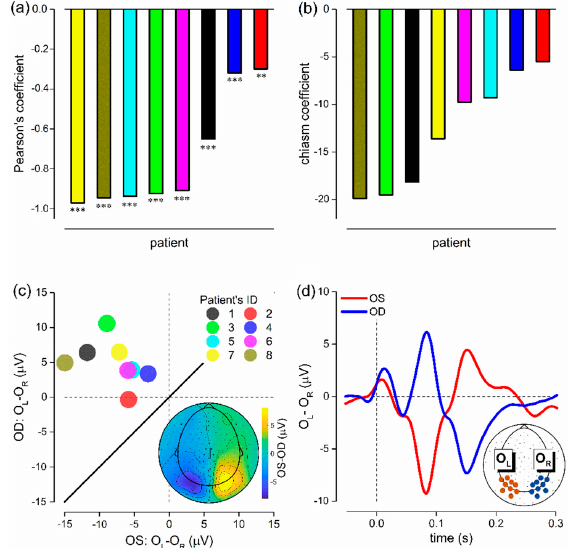
Figure 4. Misrouting of the optic pathway. ( a ) Pearson’s coefficient of correlation computed between the OS and OD mean differential activity (OL-OR, from 0.07 to 0.3 s). Each bar represents a patient (color codes for patients is consistent across panels, see panel c). The within-subject correlation was statistically significant for all patients ( p ≤ 0.0011. Asterisks mark the statistical significance: *** < 0.001, ** < 0.01). ( b ) Chiasm coefficient computed between the OS and OD mean differential activity (OL-OR, from 0.07 to 0.1 s). Each bar represents a patient. ( c ) Scatter plot showing the average dif- ferential activity for both OS and OD. Each dot represents a patient. All the dots scattered above the equality line (thick, black) indicate the presence of a significant interhemispheric difference ( p > 0.001). The topoplot inset shows the grand-average difference between OS and OD from 0.07 to 0.1 s, confirming the presence of an interhemispheric difference mostly expressed over occipital elec- trodes. ( d ) Grand-average differential (OL-OR) activity for OS (red) and OD (blue). The inset reports the position of two sets of electrodes of interest (OL in dark red, OR in dark blue). 3. Discussion Foveal hypoplasia with a substantial reduction in BCVA, usually in the range of 0.5 to 1.3 LogMAR, is a typical clinical feature in oculocutaneous and ocular albinism. In the albino phenotype, other distinctive ocular changes include nystagmus, reduced iris pig- mentation with iris translucency, reduced retinal pigmentation, misrouting of the optic nerve fibers at the chiasm, strabismus and reduced stereoscopic vision. To demonstrate selective misrouting, pattern-onset VEPs are usually performed with a technique specifi- cally designed for this purpose; thus, a conventional, simultaneous binocular VEP is not able to demonstrate this anomaly. Normal routing of the optic pathways excludes the di- agnosis of albinism [3]. The VEP is normally not necessary for the diagnosis of albinism because misrouting is implied by the observation of a typical ocular phenotype. In some patients with mild hypopigmentation (a few with OCA1B), foveal hypoplasia and no ob- vious nystagmus, a VEP may be a useful adjunct to demonstrate misrouting of the retinal to occipital projections [25,26]. MRI studies may demonstrate misrouting, but this ap- proach is not validated sufficiently to replace VEP [27].